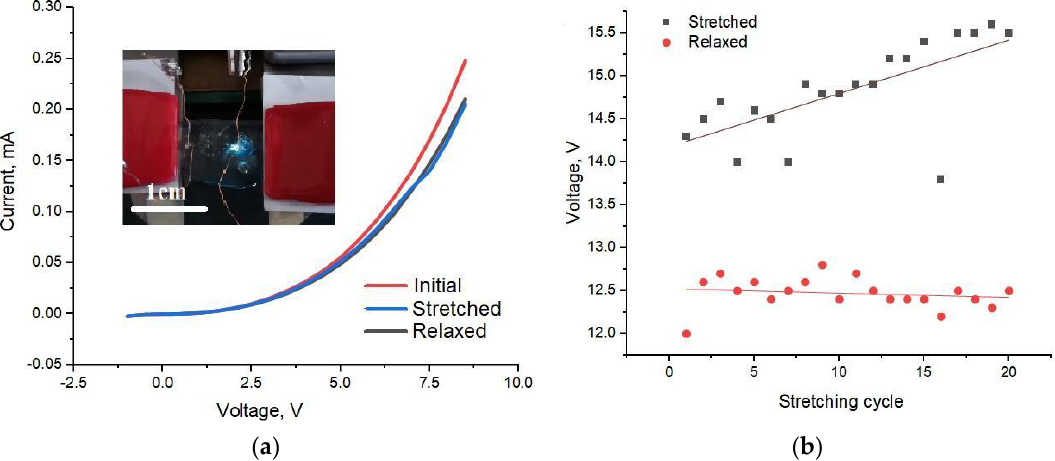
Figure 4. ( a ) I–V curves of a representative stretchable LED in initial ( red line ), stretched by 20% for the first time (blue line), and released ( black line ) states. ( b ) Working voltage during the stretching test of the LED for a constant injection current. Inset in ( a ) demonstrates a photo of the functioning stretchable LED device.